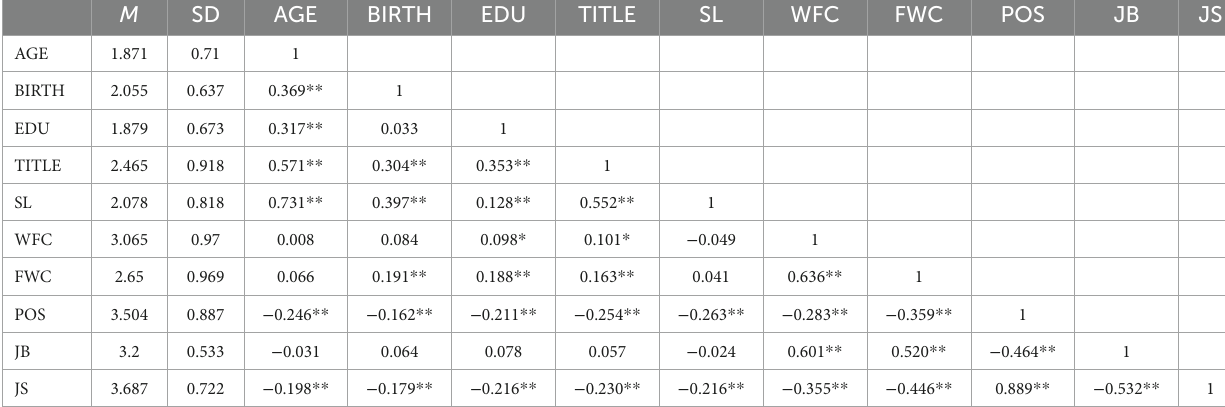
TABLE 2 Mean, standard deviation and correlation coefficient of each